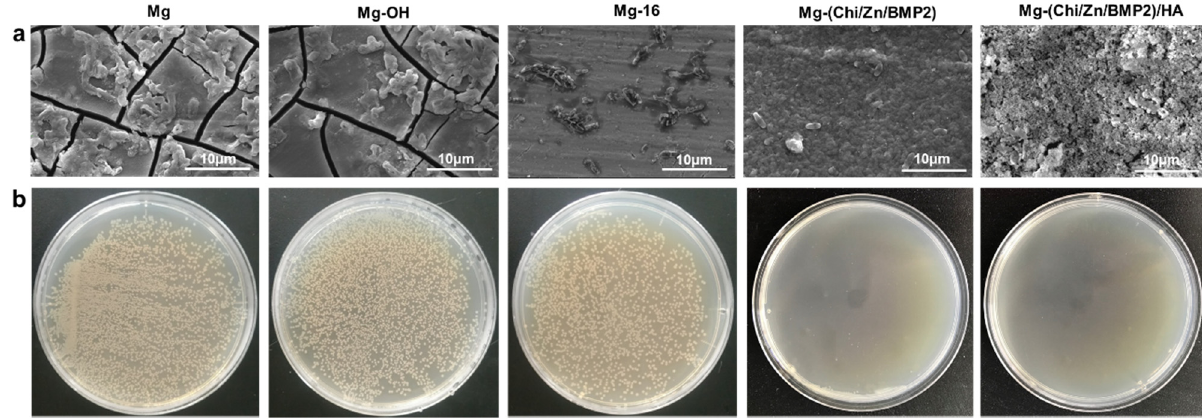
Figure 7: Typical SEM images ( a ) and photographs of colonization ( b ) by E. coli on di ff erent surfaces of magnesium